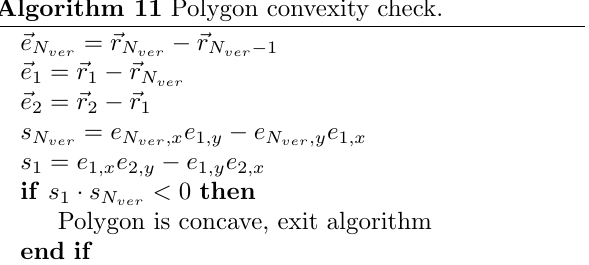
Figure 28: Polygon cleaning: the green vertices will be merged into 1, the red vertex is a ”spike” which will be removed and the blue vertices form a smooth corner which will be trans- formed into a straight line by removing the middle vertex.